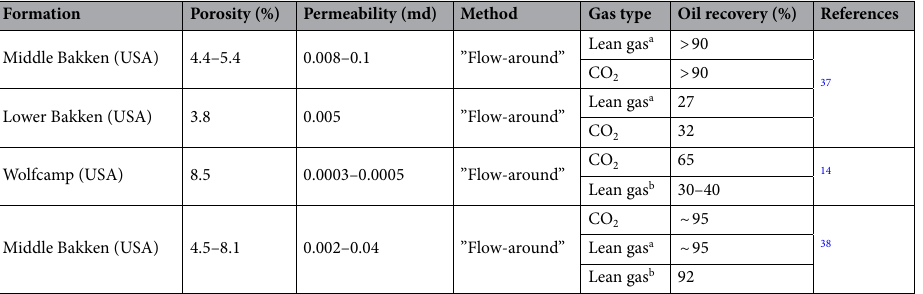
Formation Porosity (%) Permeability (md) Method Gas